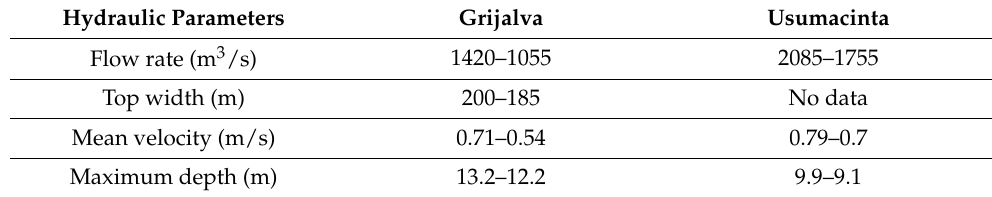
Table 1. Main hydraulic parameters obtained with ADCP for the period October–December